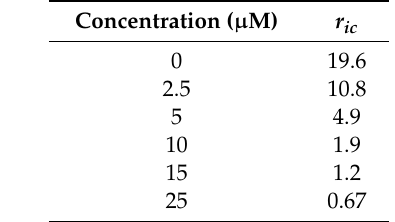
Table 1. Ion-current rectification (ICR) rectification ratios as a function of Hoechst 33258 concentration. Reprinted and adapted with permission from [26]. Copyright 2008, Future Medicine.